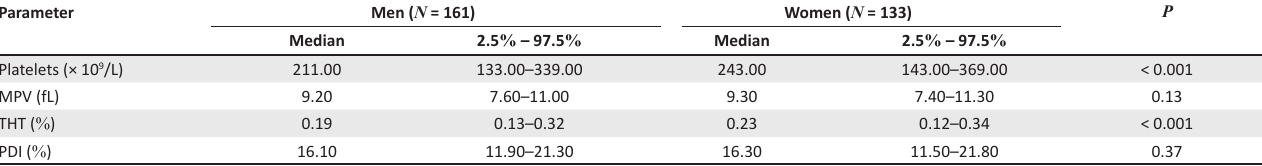
TABLE 4: Platelet parameters for men and women, Yaoundé, Cameroon, November 2015 – September 2016.